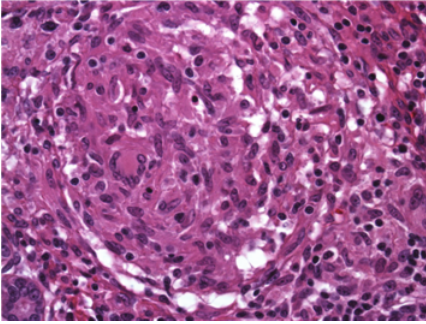
Figure 1: Histopathology showing granulomatous salpingitis. Figure 2: Histopathology showing periovarian caseating granulo- matous